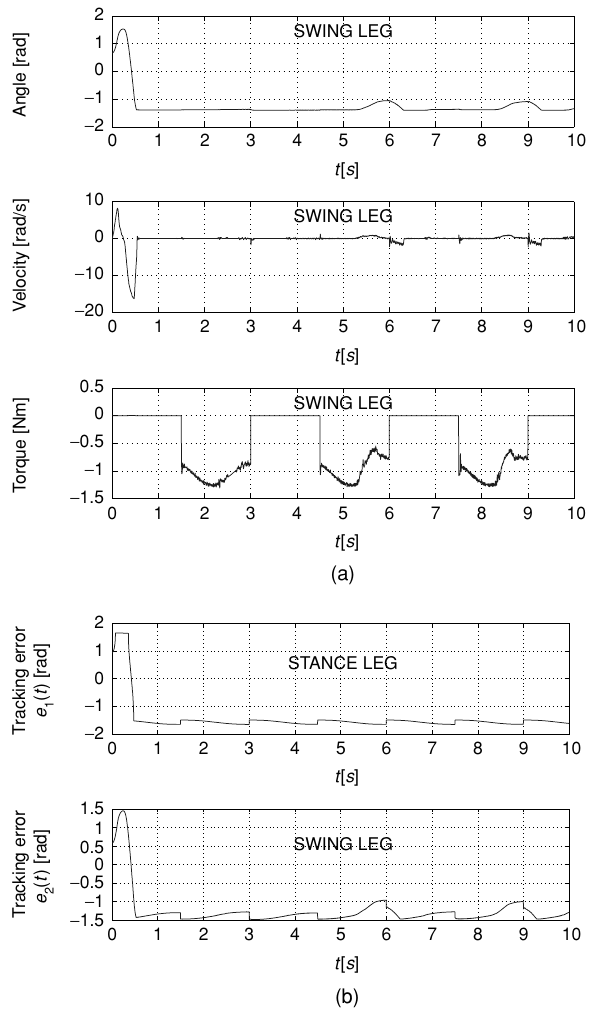
Figure 8 Experimental results for Te = 10 s. (a) States response for swing leg. (b) Tracking errors response. quadrature encoders of 512 CPR read the joint